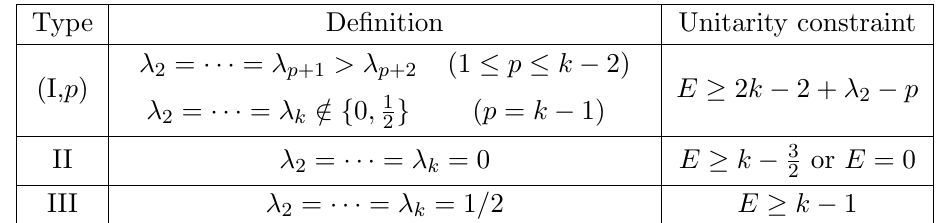
Table 3 . Unitarity conditions for so (2 ; 2 k (cid:0) 1). Here the ( (cid:21) 2 ; : : : ; (cid:21) k ) are either all integers or all half-integers, and (cid:21) 2 (cid:21) (cid:1) (cid:1) (cid:1) (cid:21) (cid:21) k (cid:21) 0. We use interchangeably the notation E = (cid:0) (cid:21) 1 .